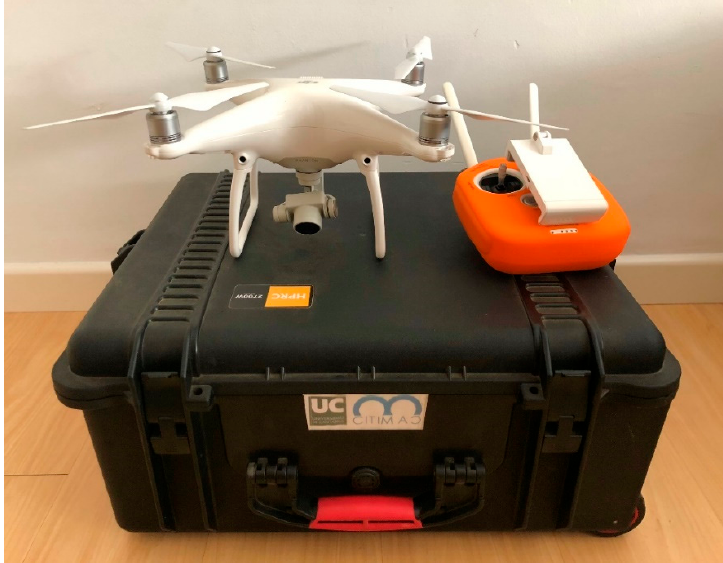
Figure 4. Quadricopter DJI Phantom 4 employed for surveying the mining remains.